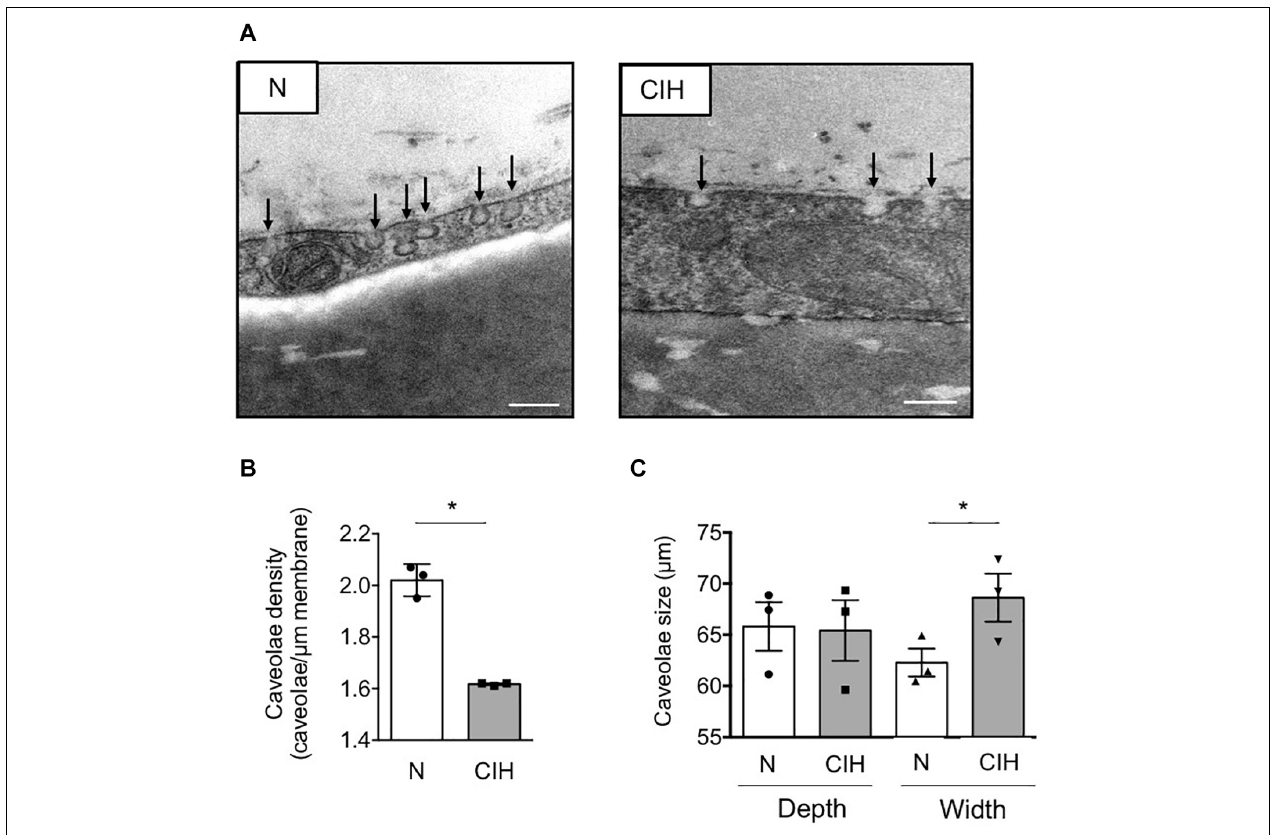
FIGURE 2 | Fat caveolae disassembly along with long-term IH-induced IR in adipose tissue. (A–C) Adipose caveolae density is altered by CIH exposure. Electron microscopy images of epididymal WAT following mice exposition to CIH for 6 weeks or normoxia (N) are presented, scale bar: 200 nm (A) . Caveolae density is provided for each condition and dot plots represent mean value for each individual animal explored (B) . Depth and width of individual caveolae were systematically measured and each dot plots represent mean value for each individual animal explored ( n = 3 per condition) (C) . Data are presented as mean ± sem. vs. normoxic mice (following Student t.test). * p < 0.05, vs. normoxic mice (following Student t